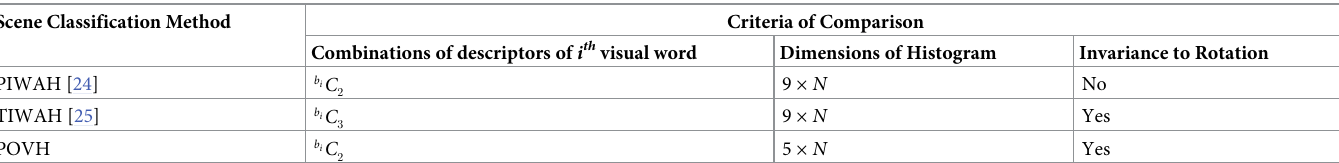
Table 6. Comparison with closely related approaches using N visual words.